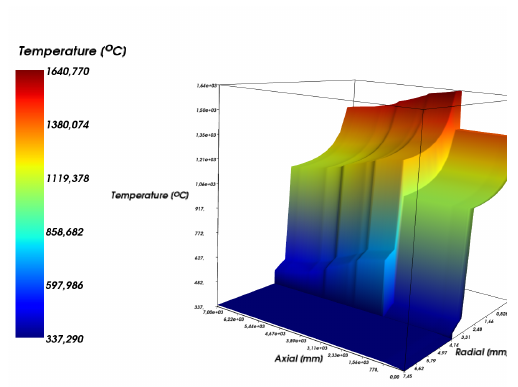
Figure 3. Coolant, cladding and fuel temperature profile.